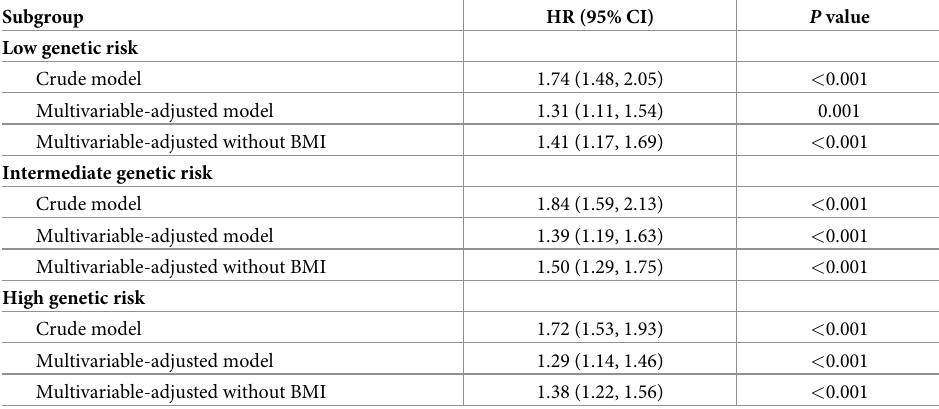
Multivariable-adjusted without BMI 1.38 (1.22, 1.56) < 0.001 HRs and 95% CI for type 2 diabetes risk for low versus high diet quality according to genetic risk categories. Cox proportional hazards models were stratified by age (in months, continuous) and adjusted for ancestry-derived principal components (1 to 4) (crude model). Multivariable-adjusted model was further adjusted for time-dependent confounders including family history of diabetes (not time-dependent, yes or no), hypertension (yes or no), hypercholesterolemia (yes or no), menopausal status (premenopausal or postmenopausal [never, past, or current menopausal hormone use], women only), BMI (quintiles of kg/m 2 ), smoking status (current, former, and never), physical activity (quintiles of MET hours/week), and total energy intake (quintiles of total caloric intake/day). An additional model was conducted without adding BMI as a covariate. Fixed-effects inverse variance weighted meta- analysis was used to combine cohort-specific results. BMI, body mass index; CI, confidence interval; HR, hazard ratio.